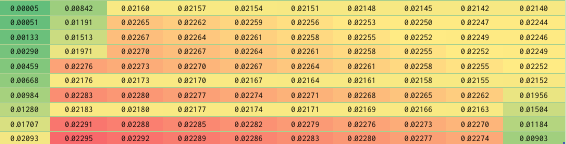
Table 8. Maximum distances of the fitting straight lines on the left image of the GeoEye dataset